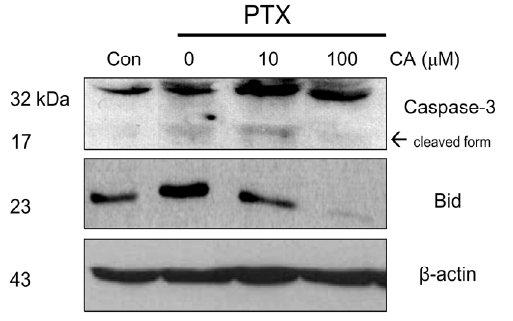
Figure 3. CA attenuates PTX-induced activation of pro-apoptotic proteins. A549 cells were pre-treated with the indicated dose of CA and PTX or PTX alone. Afterwards, cells were harvested and lysed. The whole cell lysates were analyzed using Western blot assay. Beta-actin was used as an internal